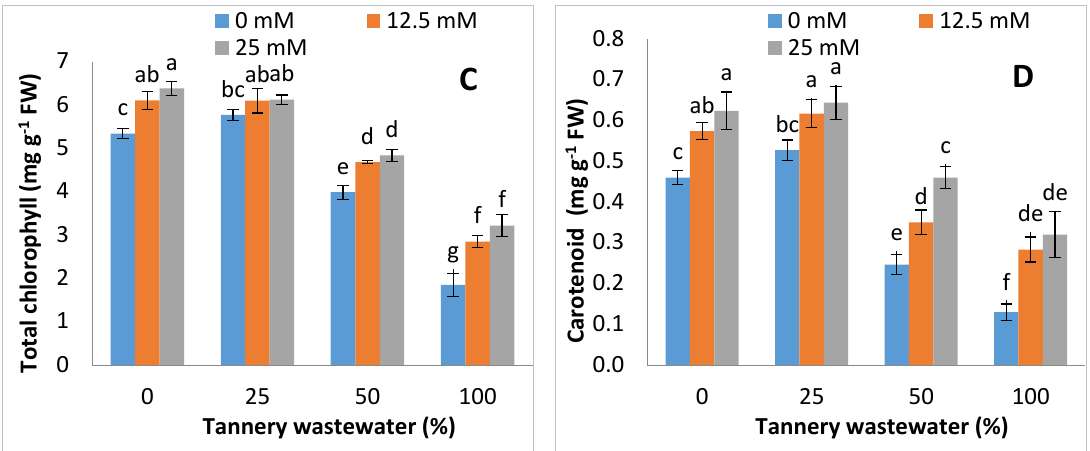
Figure 3. Graphs showing effect of foliar spray of zinc chelated lysine (0, 12.5, 25 mM) on Chlorophyll a ( A ), Chlorophyll b ( B ), total Chlorophyll content ( C ) and carotenoids ( D ) of Maize plants, growing under 0, 25, 50, 100% concentration of tannery wastewater. Values are means of three replicates. Statistical analyses were carried out by ANOVA, followed by Tukey’s Post-Hoc test.